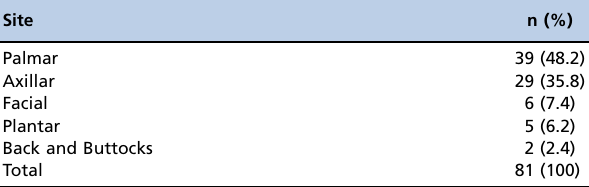
Table 2 - Primary site of hyperhidrosis as the chief complaint.